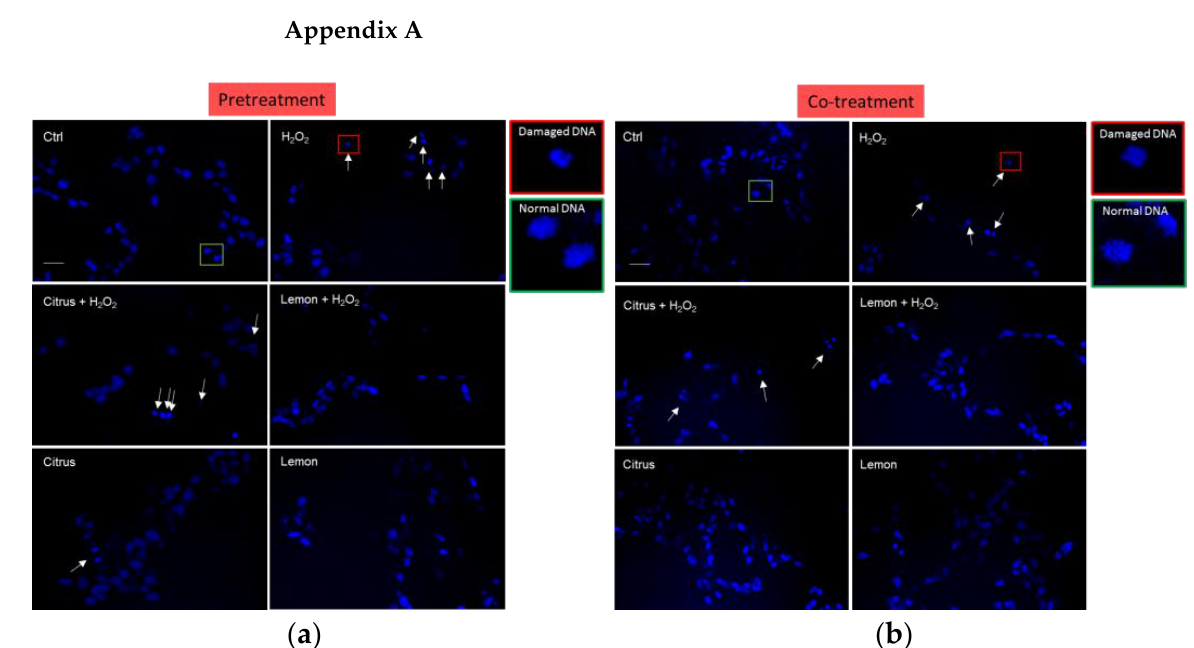
Figure A1. Effects of commercial (citrus) and lemon IntegroPectin (lemon) pectins on DNA damage: microscopy inspection for ( a ) pretreatment, and ( b ) co-treatment images of untreated cells (Ctrl) or treated with pectins or with H 2 O 2 alone, or in combination with pectins. Bar: 100 µ m. The square of the enlargements highlights the normal end of the damaged DNA.